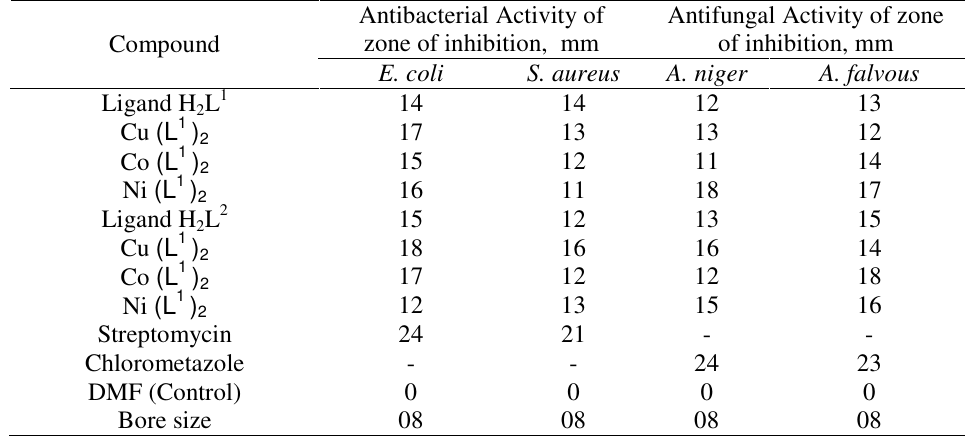
Table 5. Antimicrobial activity of the ligands H